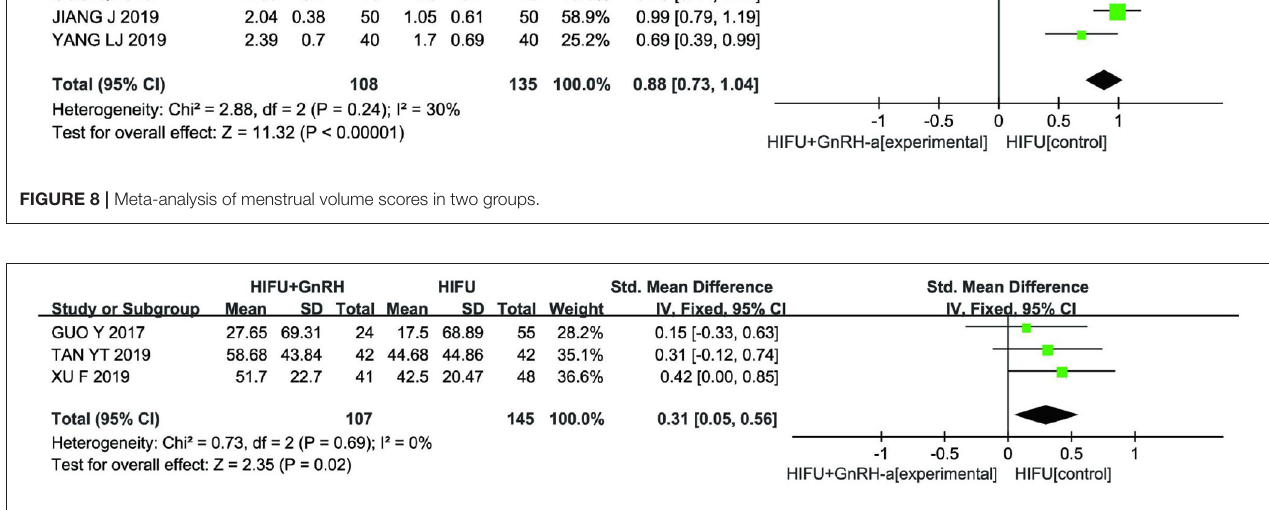
FIGURE 9 | Meta-analysis of serum CA-125 levels in two